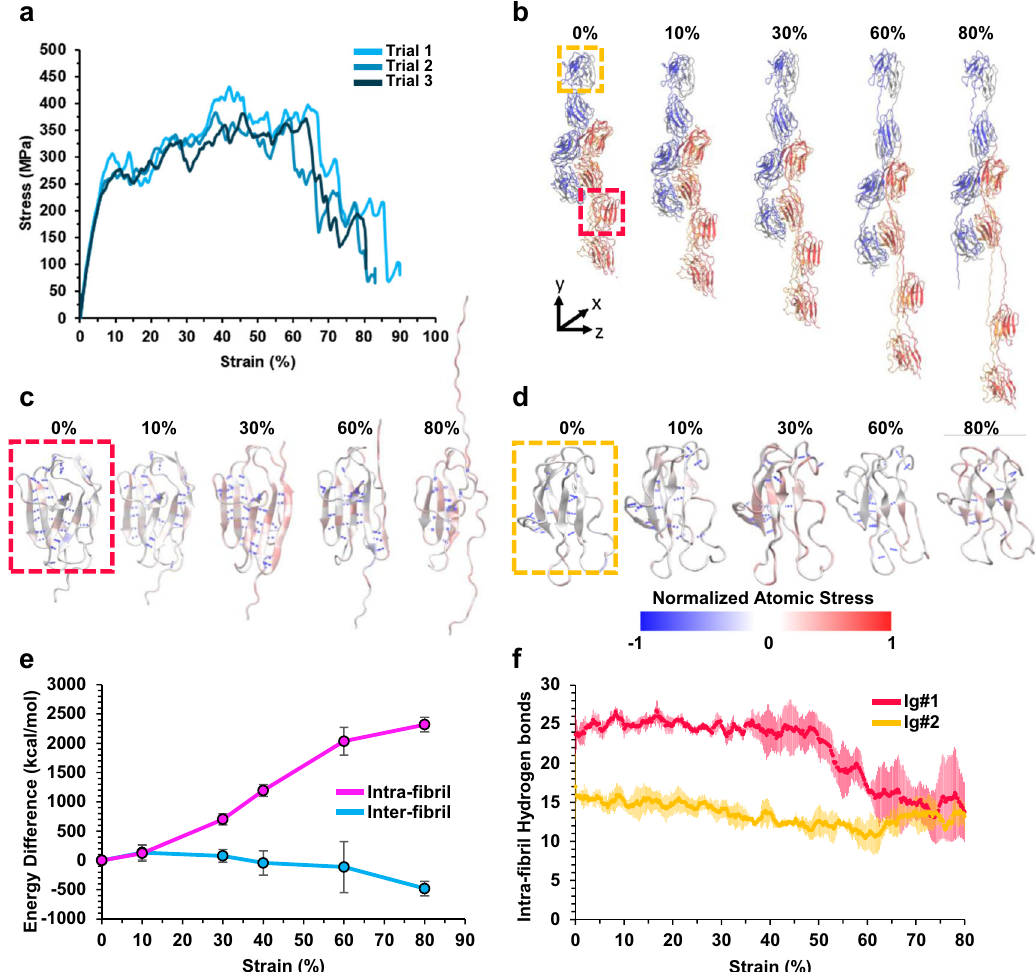
Fig. 4 Molecular dynamics simulation of uniaxial tensile testing of a model titin fi ber. a Representative uniaxial tensile stress-strain curves of the model titin fi ber. b Snapshots of the molecular dynamics simulation of the titin fi ber under tensile deformation. c , d Normalized atomic stress along the y-axis during extension of the titin fi ber from 0 to 80% strain. Selected Ig-like domains are shown in dashed boxes. The Ig-like domain in the red and yellow boxes in ( b ) are shown in ( c , d ), respectively. e Average changes in intra- and inter- fi bril (pink and blue, respectively) non-bonded energies (including Van der Waals, electrostatic, and hydrogen bonds) over the course of the simulation. Error bars are the standard deviation of three trials. f Average total number of intra- fi bril backbone-backbone hydrogen bonds in the two selected Ig-like domains in ( b – d ) over the course of the tensile test. Error bars (shown as red or yellow bars) are the standard deviation of three trials. Source data are provided as a Source Data fi